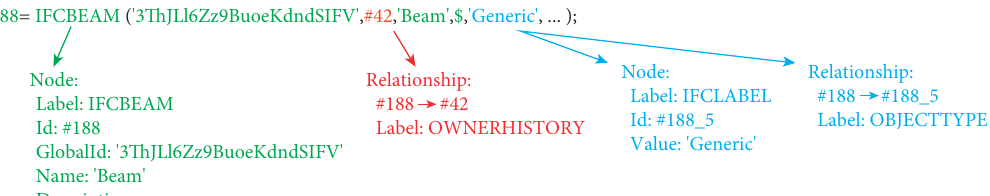
Figure 8: Example of nodes and relationships created from an IfcBeam